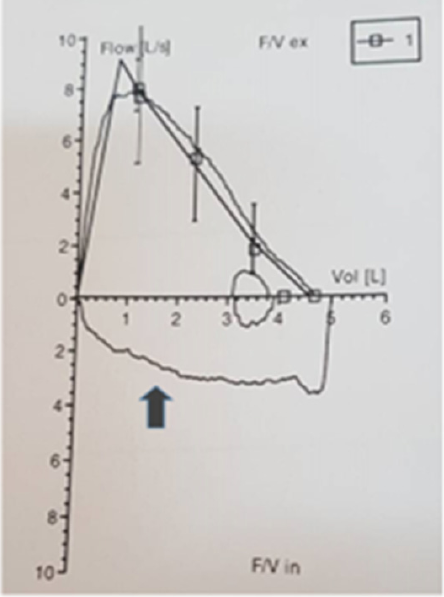
Figure 2. Expiratory flow pattern.